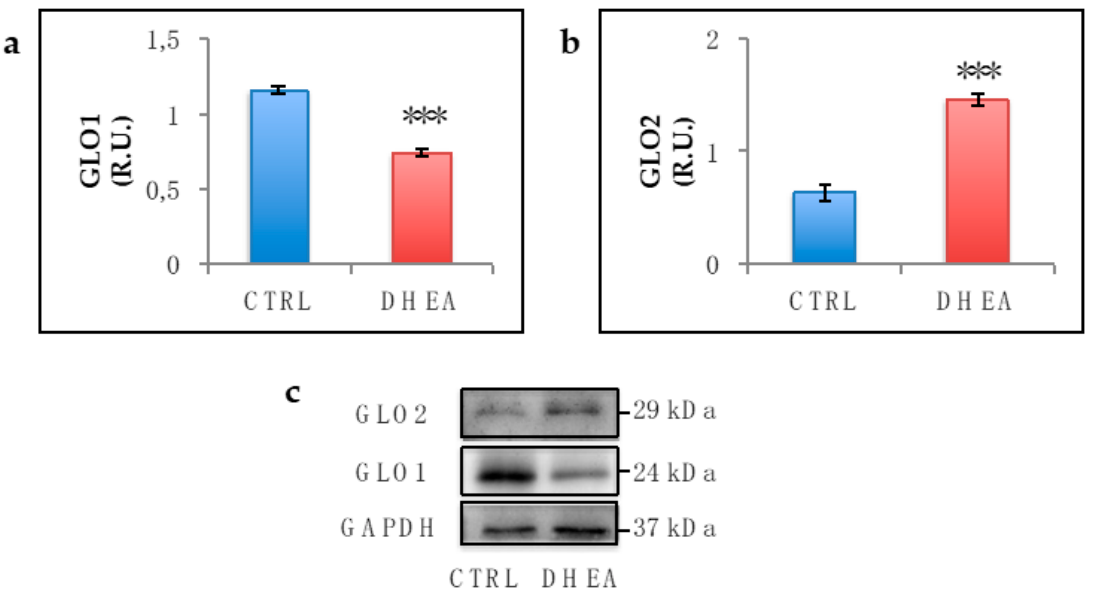
Figure 5. Western blot analysis of glyoxalase 1 (GLO1) ( a ) and GLO2 ( b ) and representative Figure 5